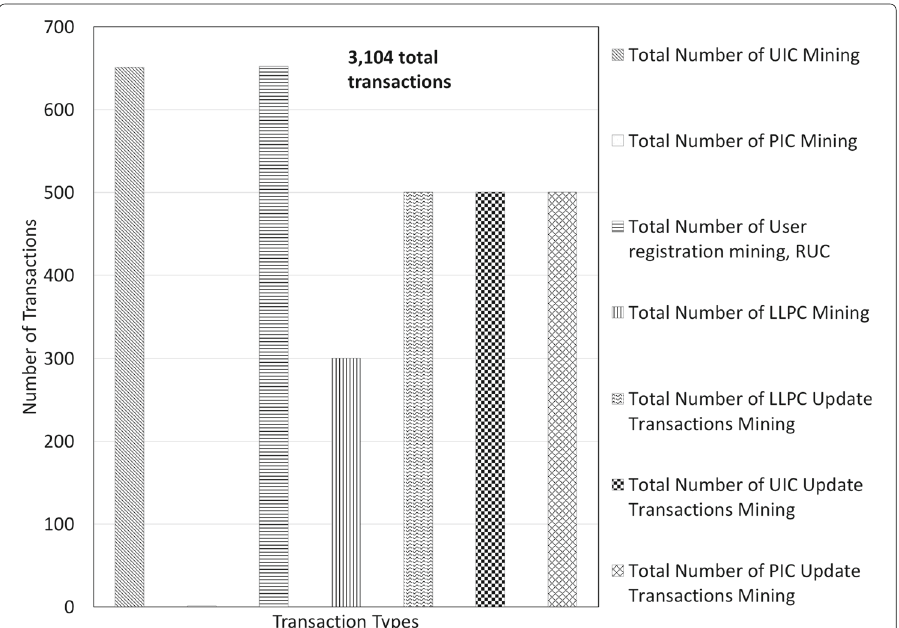
Fig. 6 Smart contract mining operations. This figure shows the statistical representation of various smart contract update operations resulting from different processes including user registration, learning records insertion, granting permissions, and record indexing